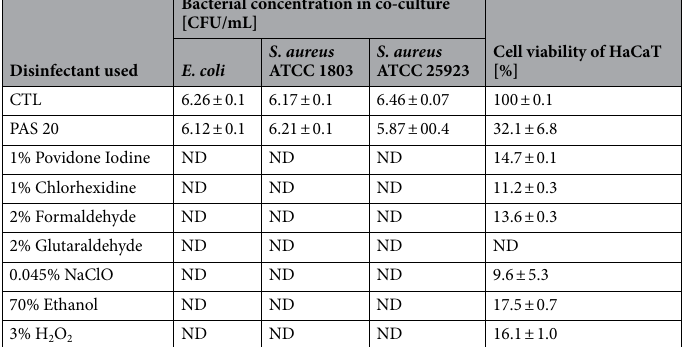
Bacterial concentration in co-culture [CFU/mL]